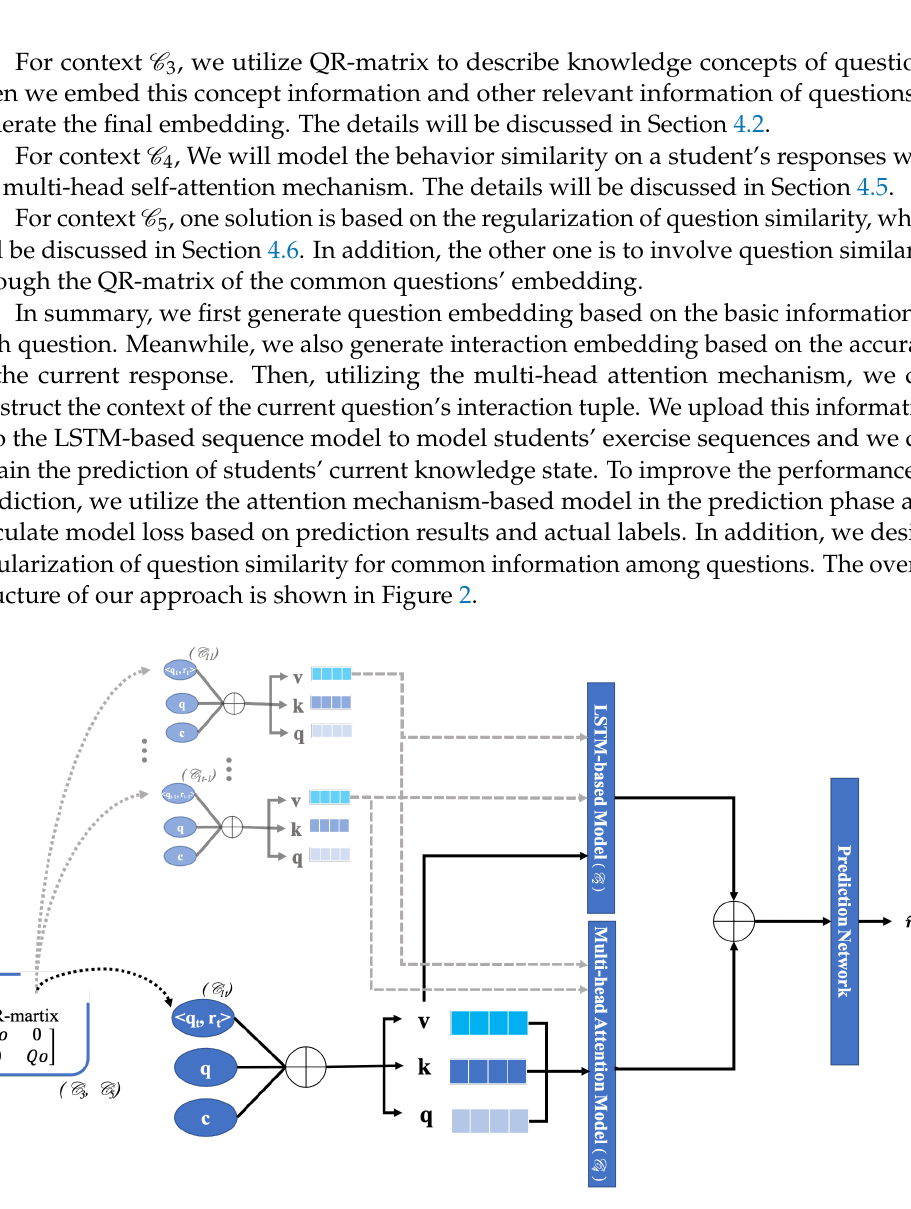
Figure 2. ContextKT Structure Diagram. We construct the model based on five contexts. To be specific, Context C 1 , C 3 and C 5 are related to the questions and students’ corresponding performances. This information is treated as input in ContextKT. Context C 2 and C 4 are both process during study. So we use LSTM and multi-ahead attention to represent